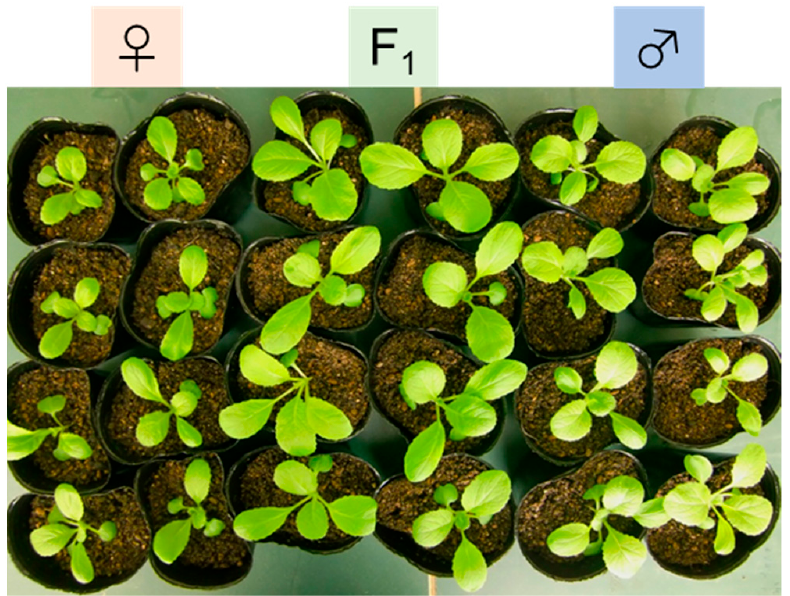
Figure 3. Increased plant size in F 1 (W39) compared with parental lines (S27 female inbred and R29 male inbred line) at 18 days after sowing in Chinese cabbage. The data are from [39].